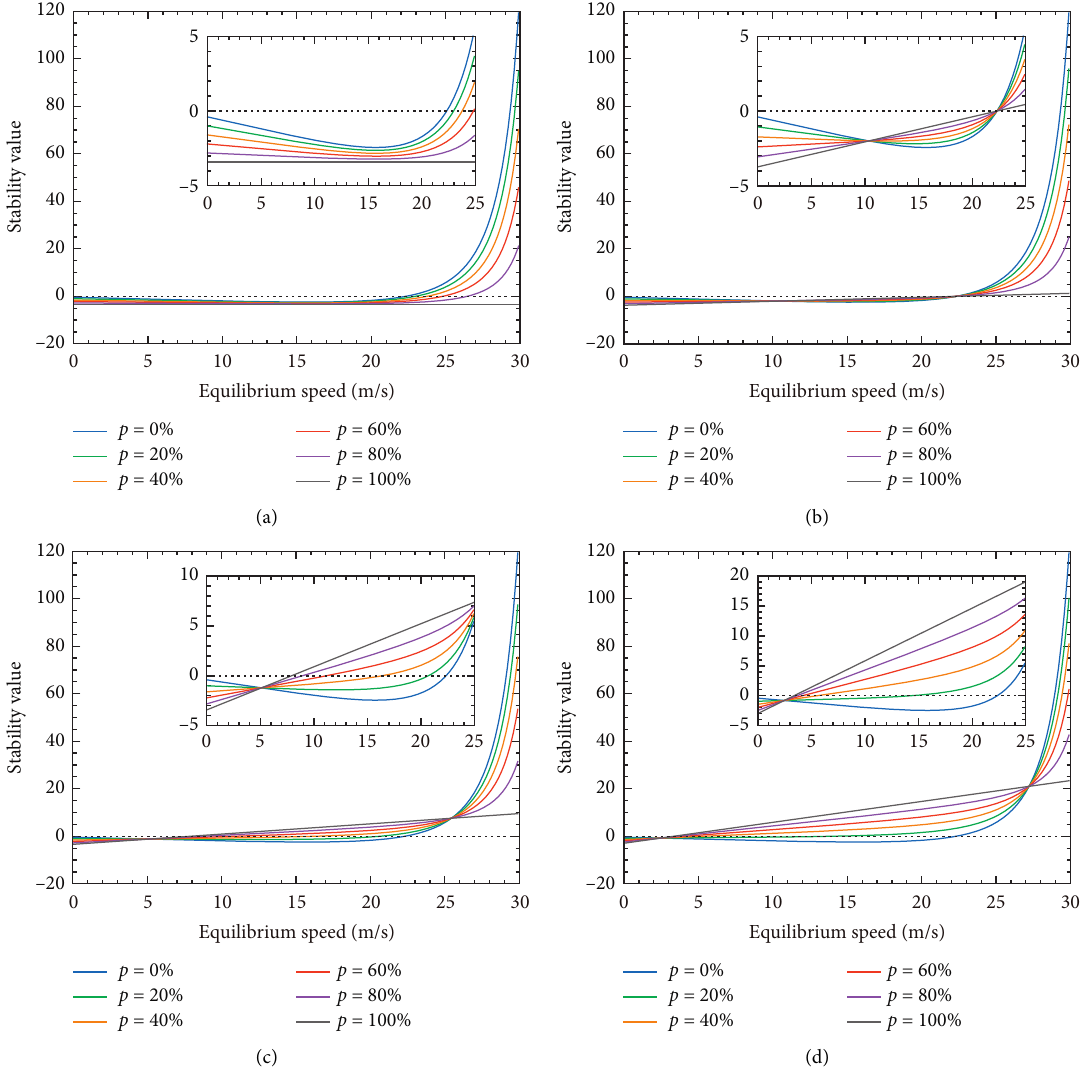
� 1 . 1s. (b) VTG policy with h